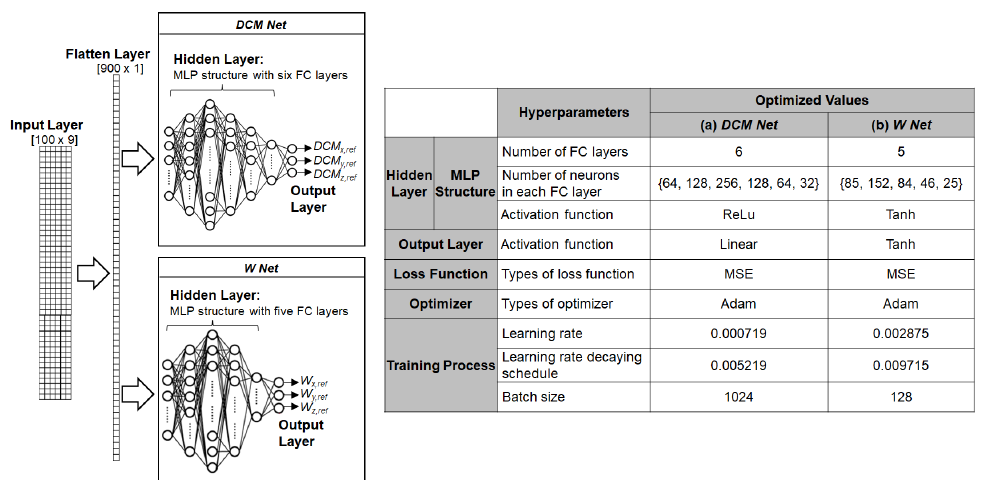
Table 2. Performance of Three Optimized DNN Structures for DCM Net and W Net of the Robot Simulator.